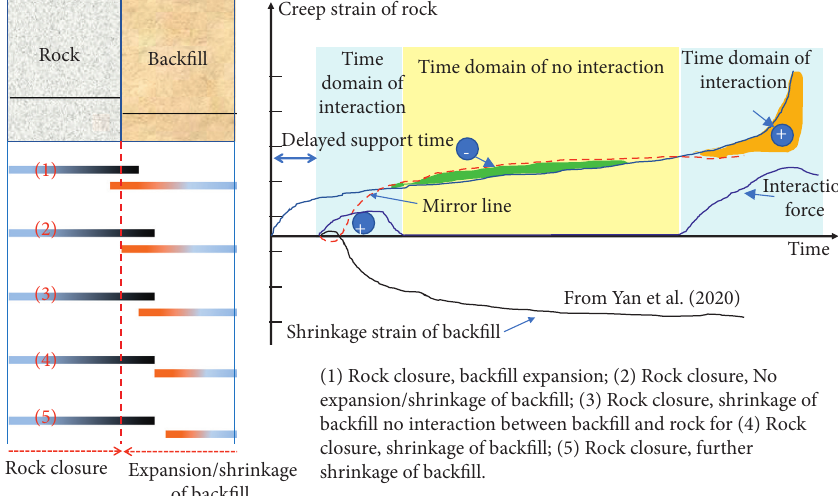
Figure 1: Diagram of the time-dependent interaction mechanism between backfill and rock.